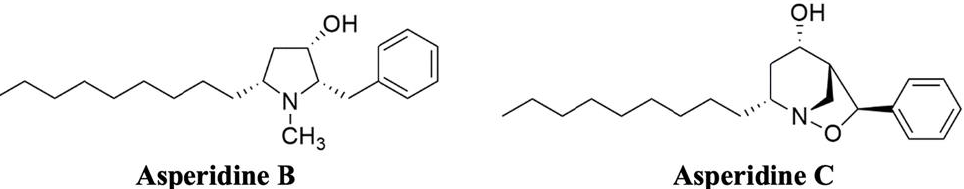
Figure 1. Structures of asperidine B (preussin) and asperidine C isolated from the soil-derived fungus Aspergillus sclerotiorum PSU-RSPG178.